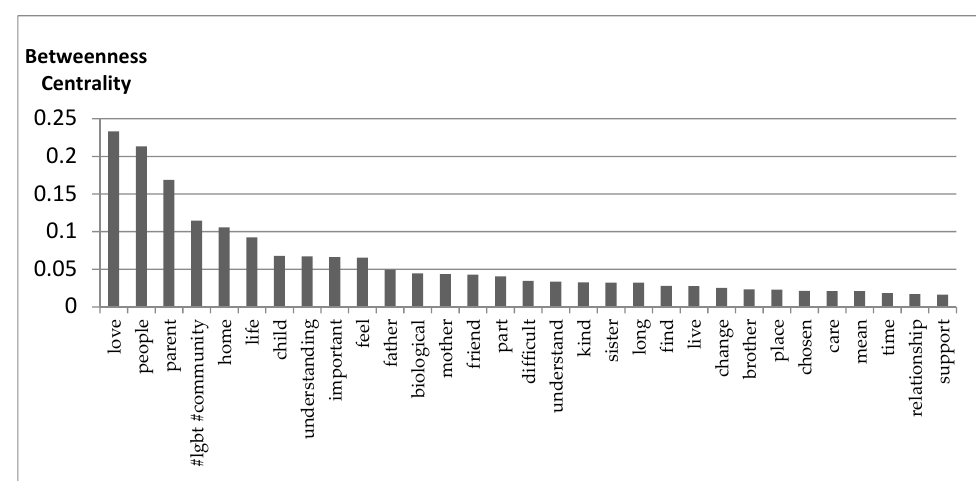
Figure 3. Influential discourse elements .